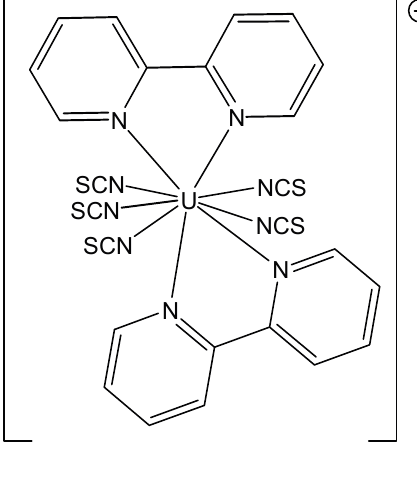
Figure 10. Solid-state structure of [Et = 2.422; U–N (Å): U–N NCS